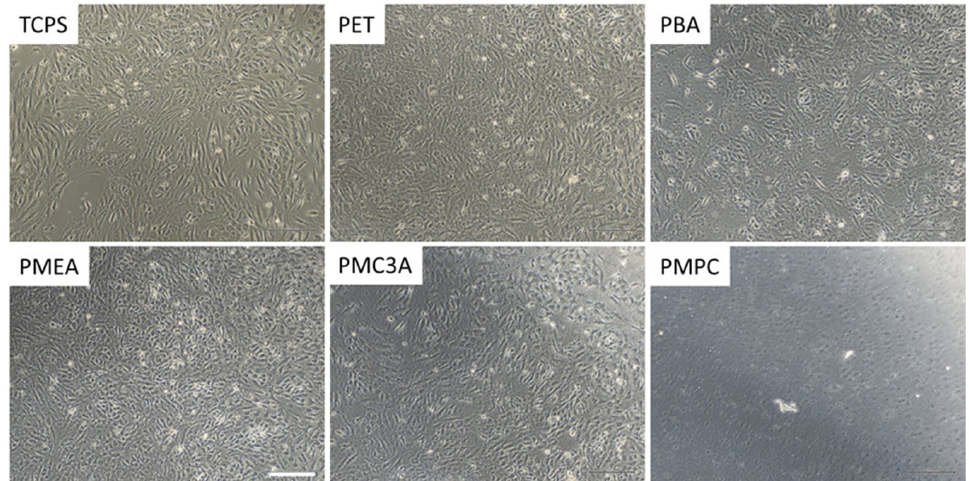
Figure 3. Phase-contrast micrographs of the HUVECs cultured for 120 h on PMEA-analogous polymers and on TCPS, PET, and PMPC as controls (scale bar = 200 μ m).